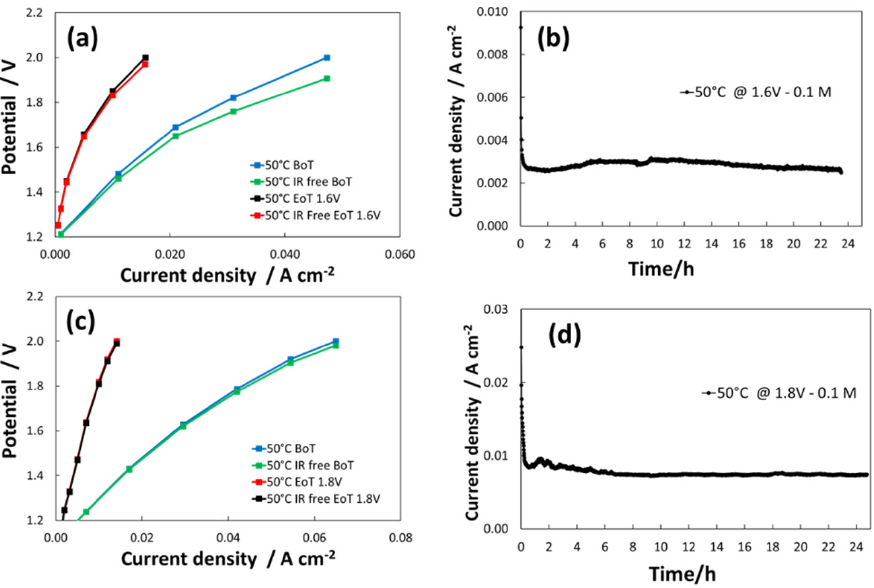
Figure 6. ( a ) Raw and IR-free polarisation curves before (BoT) and after (EoT) a potentiostatic test at 1.6 V. ( b ) Potentiostatic test at 1.6 V/cell. ( c ) Raw and IR-free polarisation curves before (BoT) and after (EoT) a potentiostatic test at 1.8 V. ( d ) Potentiostatic test at 1.8 V/cell. Cell-based on CuOx – Sustainion-NiFeOx, CO 2 feed at the cathode, 0.1 M NaHCO 3 feed at the